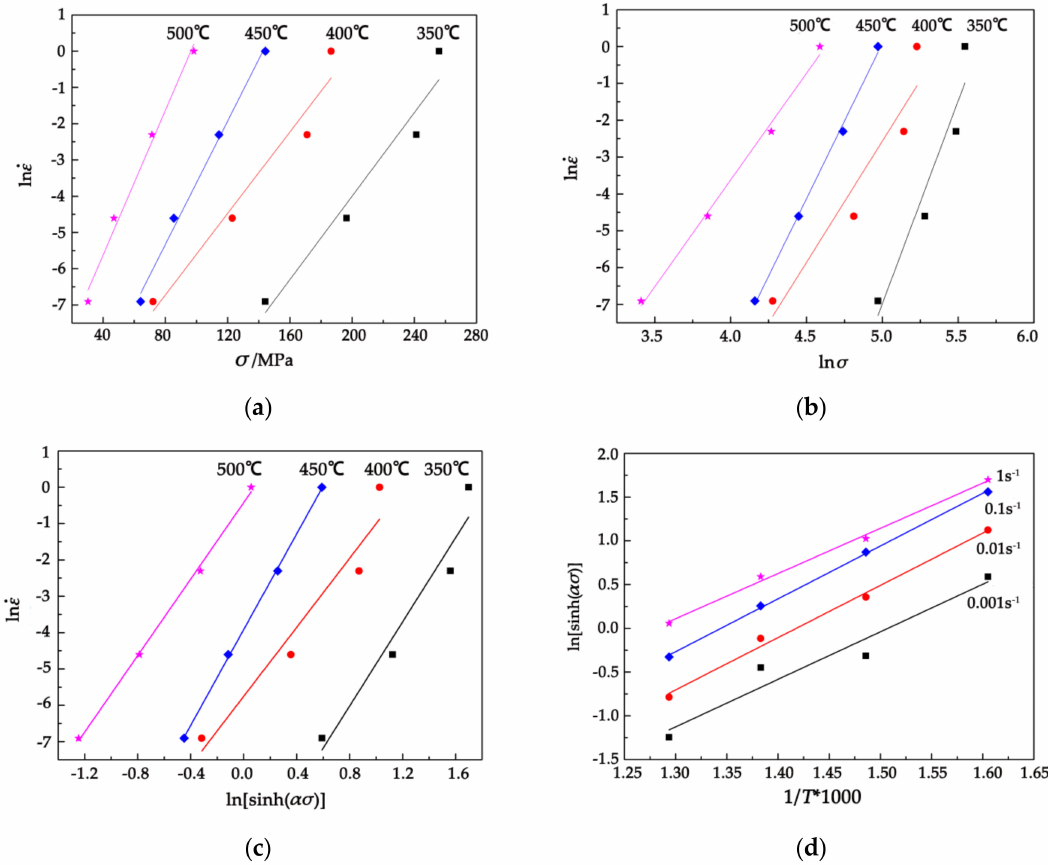
. . ε − ln σ ; ( b ) ln ε − σ ;